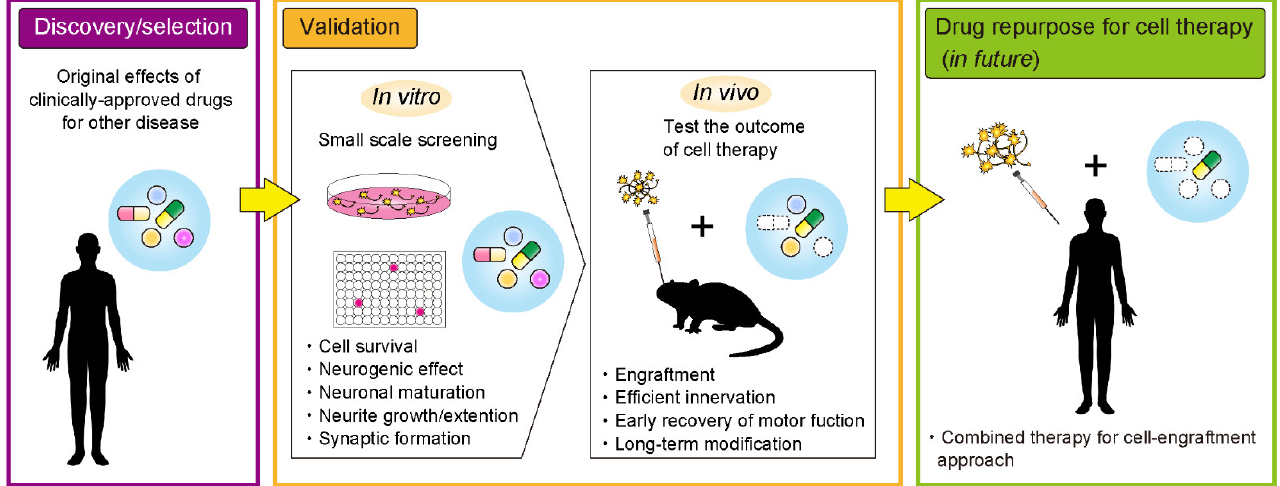
Figure 1. An overview of the drug repurposing process towards more effective cell transplantation therapy for neurological diseases.